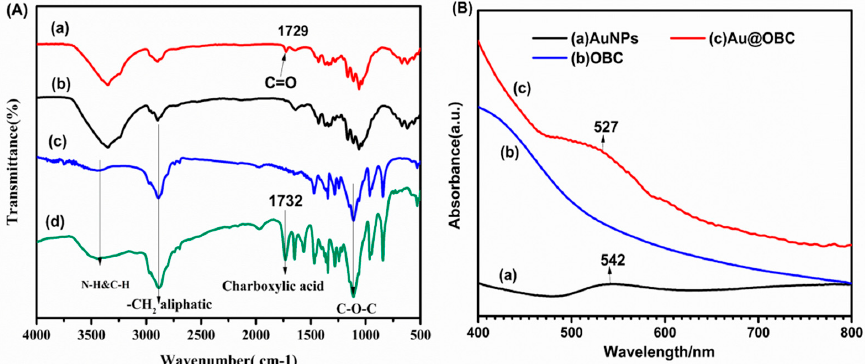
Figure 4. ( A ) FT-IR spectrum of (a) Au@OBC, (b) OBC, (c) BC, (d) PF, and (e) CPF. ( B ) UV-Vis absorption of aqueous suspensions of (a) unsupported AuNPs, (b) OBC, and (c)